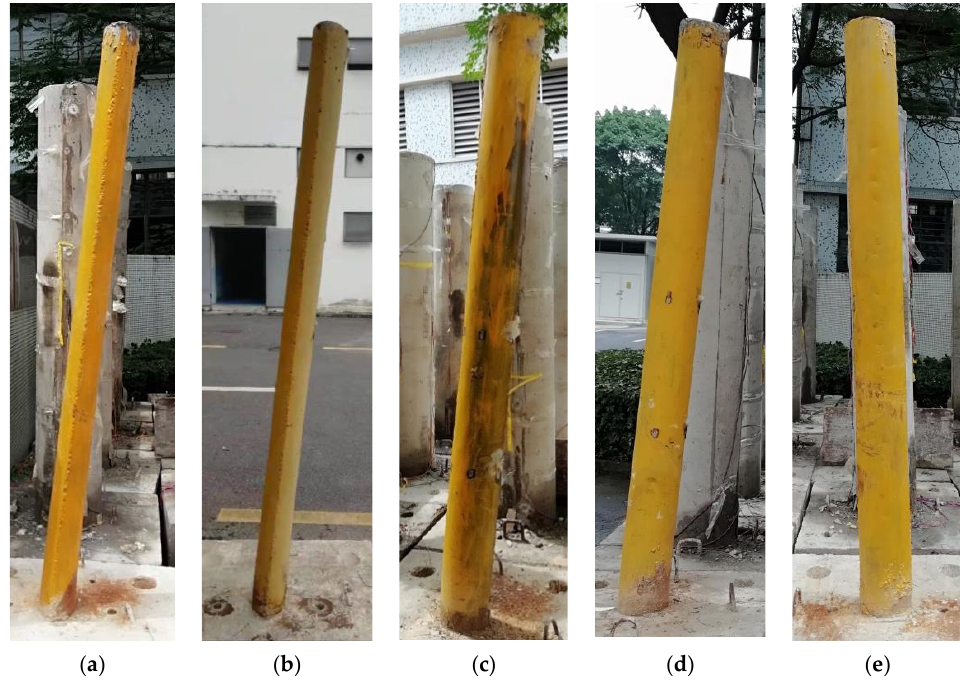
Figure 4. Global failure patterns of the specimens. ( a ) E-120-I; ( b ) E-120-U; ( c ) E-180-I; ( d ) E-180-U; ( e ) C-180-I.